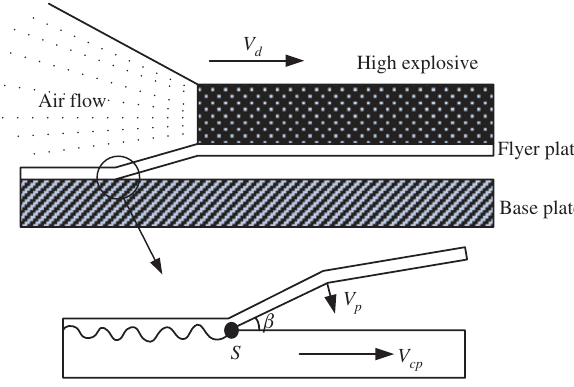
Figure 1: Schematic drawing of the explosive welding with the larger view of collision